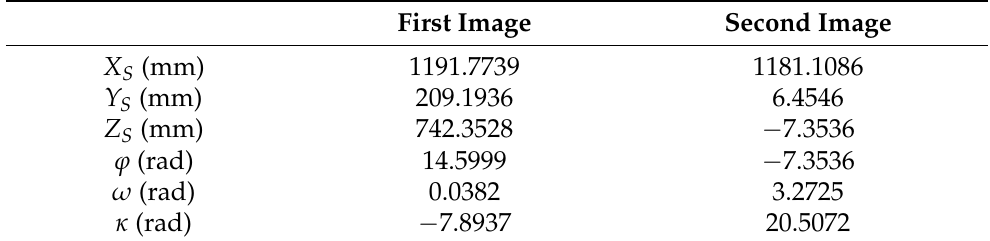
Table 4. The elements of exterior orientation of the two images in first